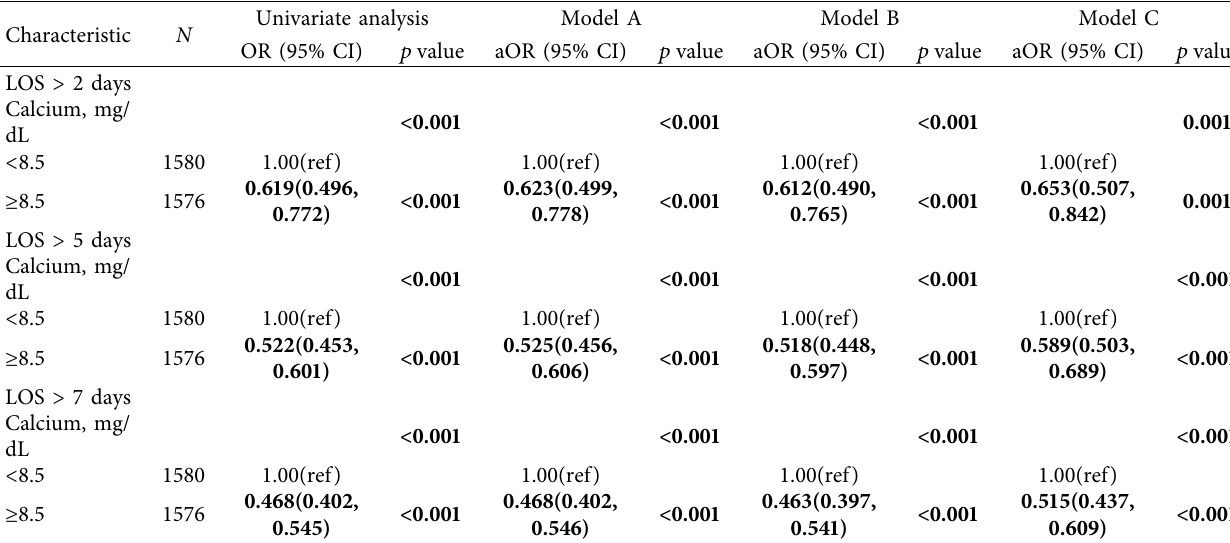
Table 2: Relative risk of having a hospital LOS of > 2, > 5, or > 7 days was calculated according to the calcium level in different groups.